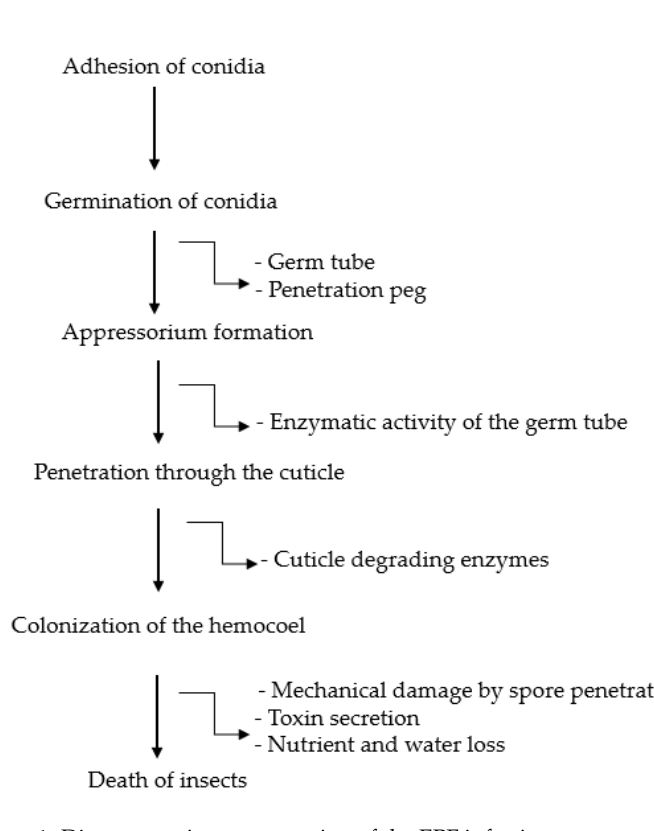
Figure 1. Diagrammatic representation of the EPF infection process on insects.